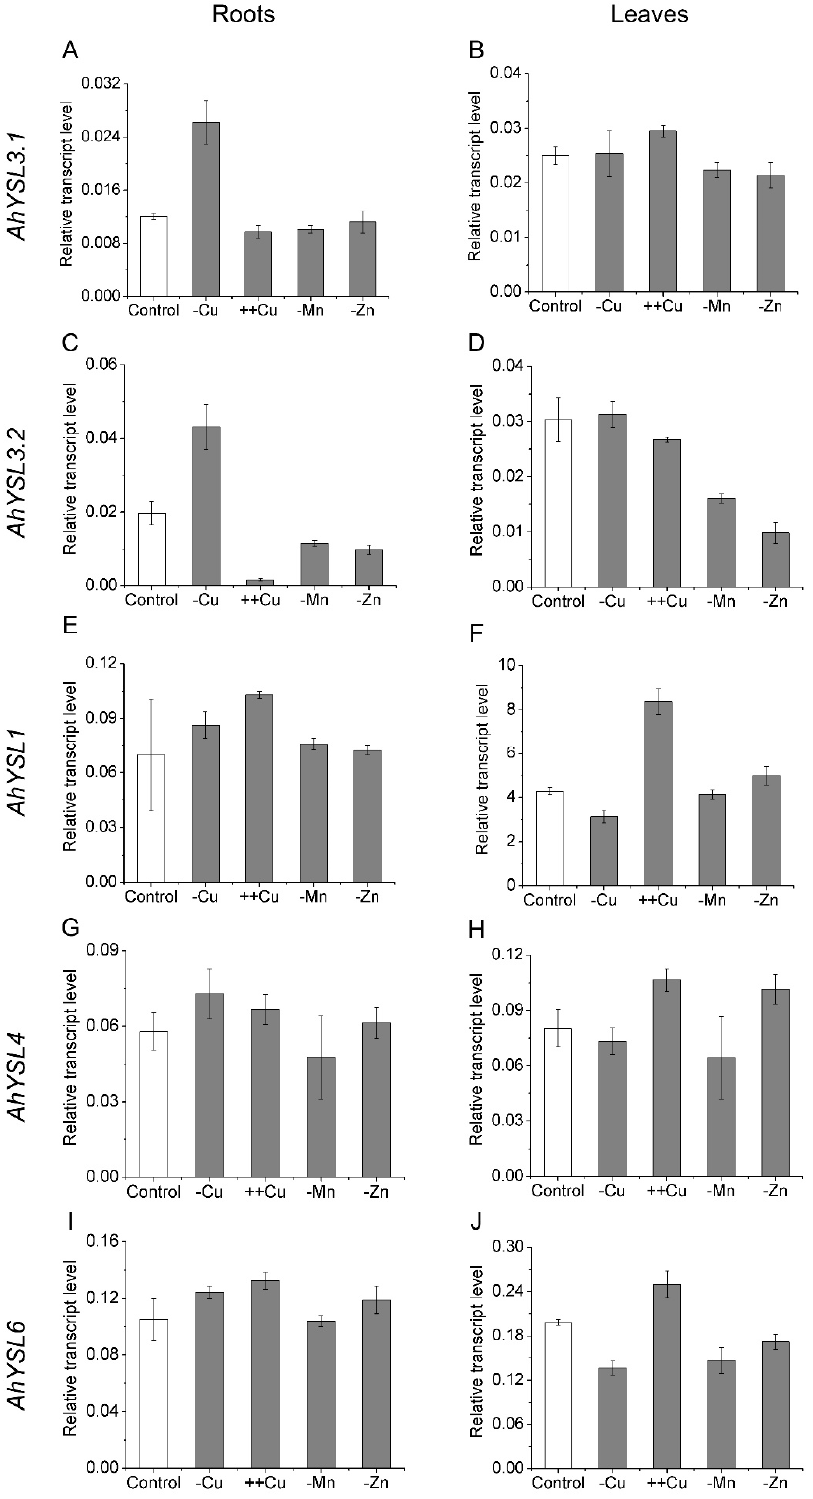
Figure 1. Expression pattern of AhYSL genes in response to various metal treatments. Peanut plants were cultured in normal nutrient solution (control) or treated with Cu deficiency (–Cu), excess Cu (++Cu, 25 μ M Cu), Mn deficiency (–Mn), or Zn deficiency (–Zn) in hydroponics for 5 days. ( A , B ) AhYSL3.1 . ( C , D ) AhYSL3.2 . ( E , F ) AhYSL1 . ( G , H ) AhYSL4 . ( I , J ) AhYSL6 . Roots ( A , C , E , G , I ) and leaves ( B , D , F , H , J ) of peanut were sampled using five biological replicates. Vertical bars indicate expression levels relative to the control, ubiquitin . Error bars indicate standard deviation.